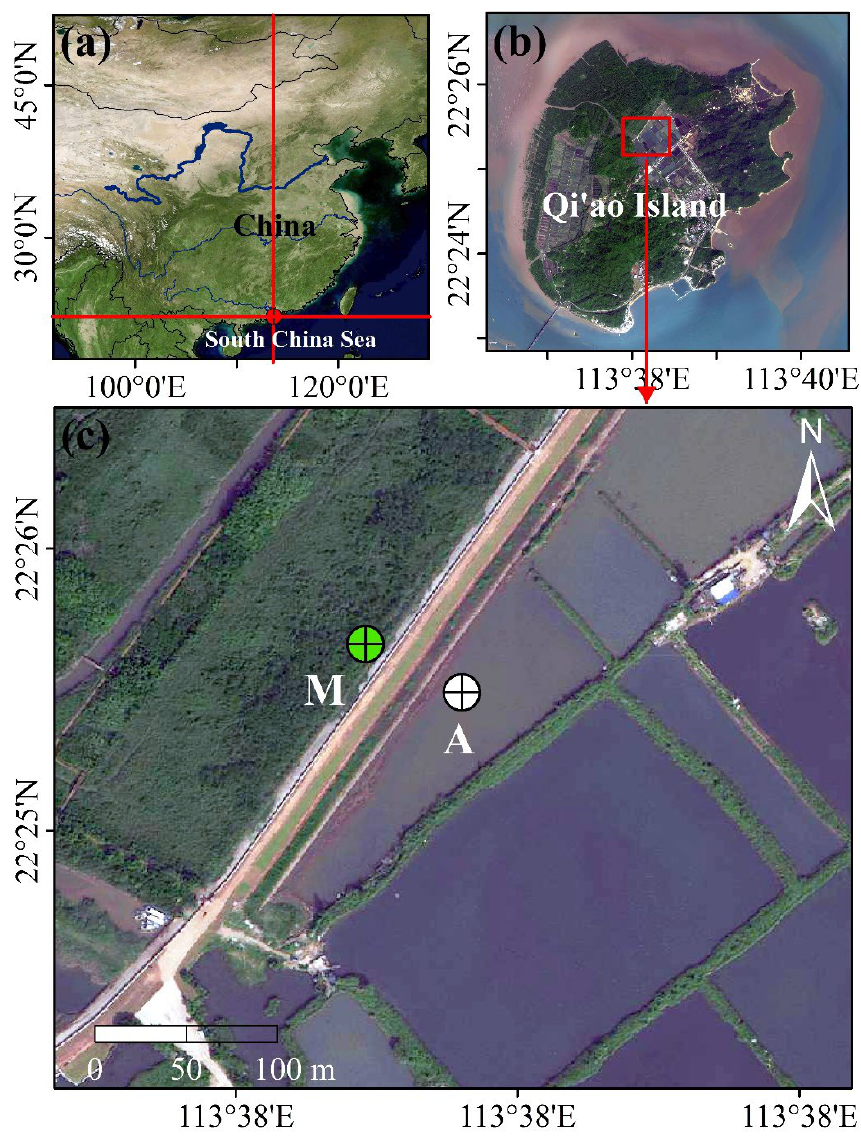
Figure 1. Study area ( a , b ) and sampling sites ( c